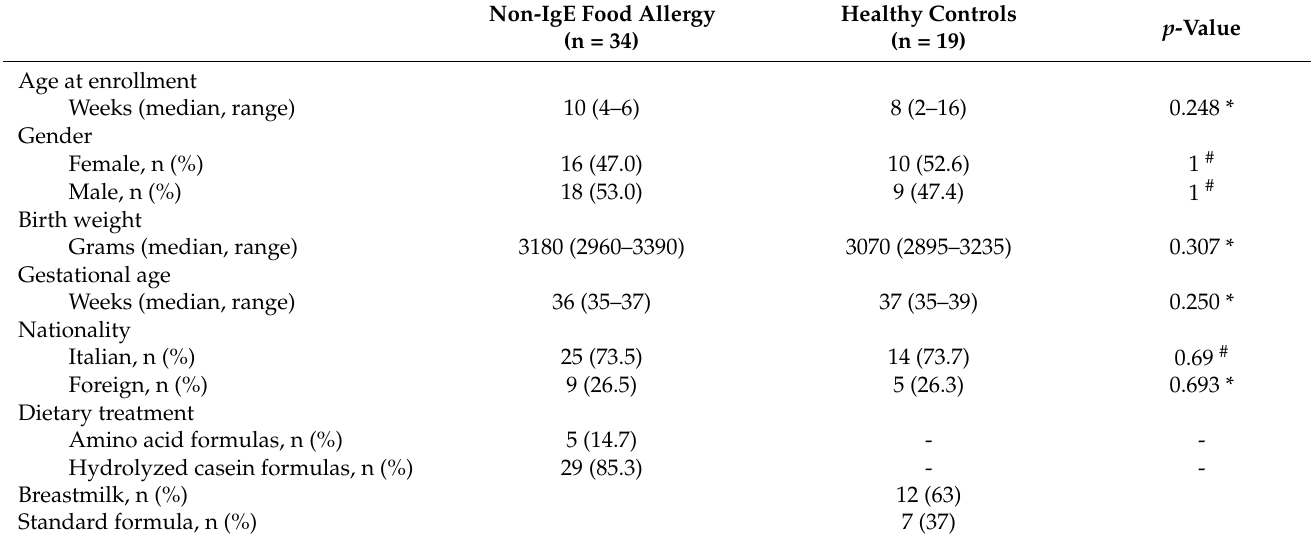
Table 2. Subject characteristics.